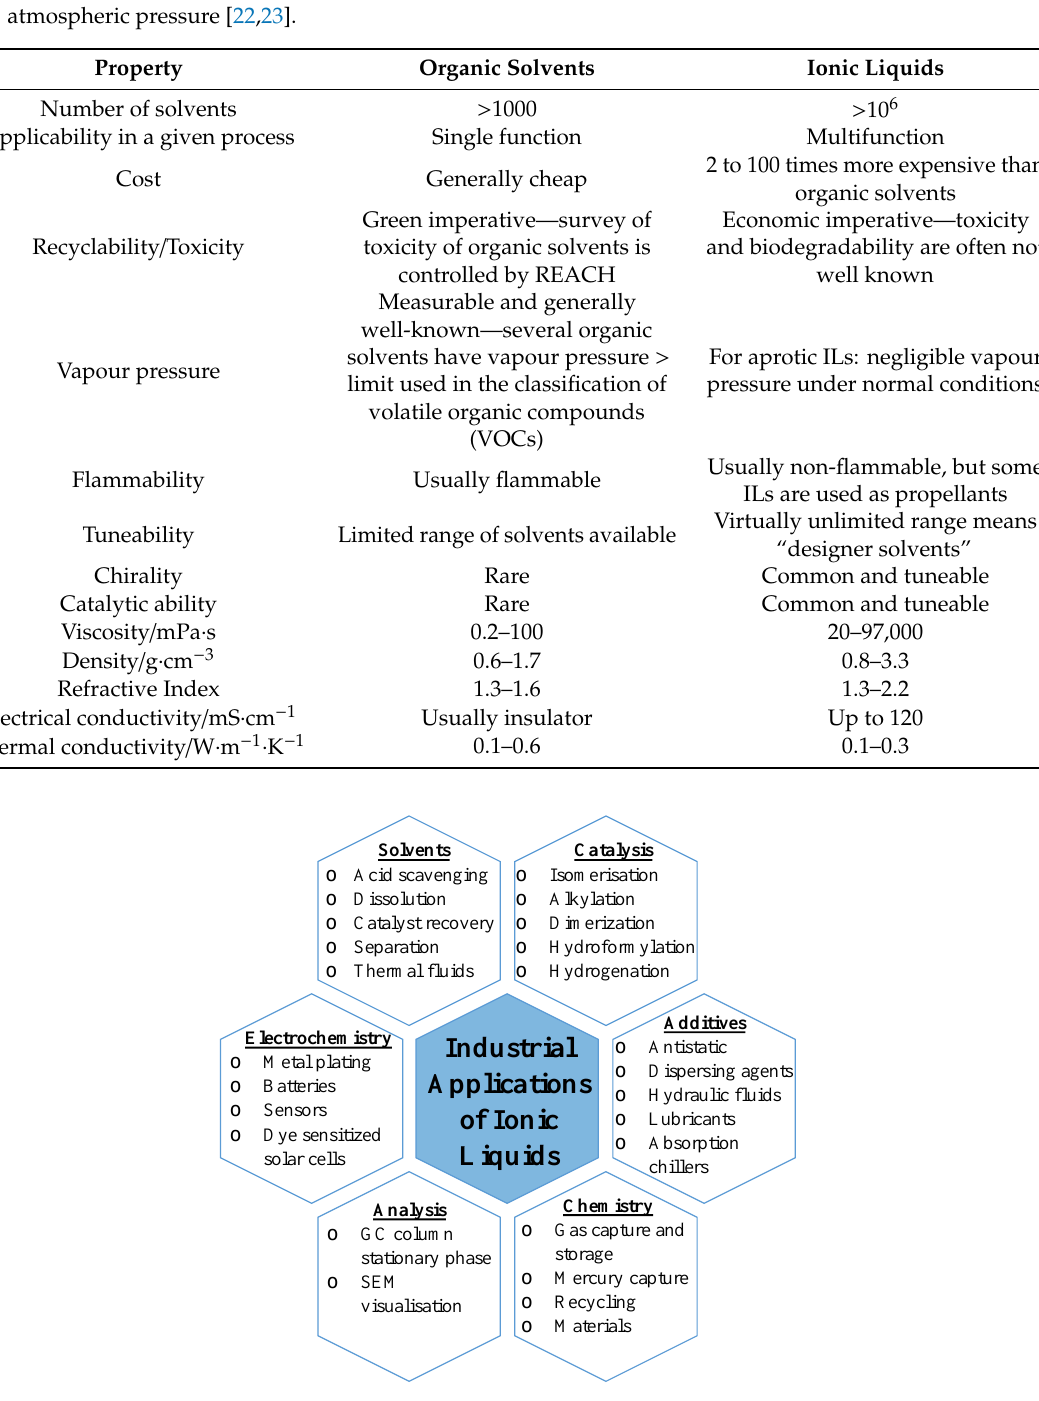
Figure 2. Illustration of some well-known applications of ionic liquids. Table 1. Comparison of organic solvents with ionic liquids (ILs), updated from work by Plechkova and Seddon [19]. Range of values were analysed from the NIST ILThermo database at 25 °C and atmospheric pressure [22,23].